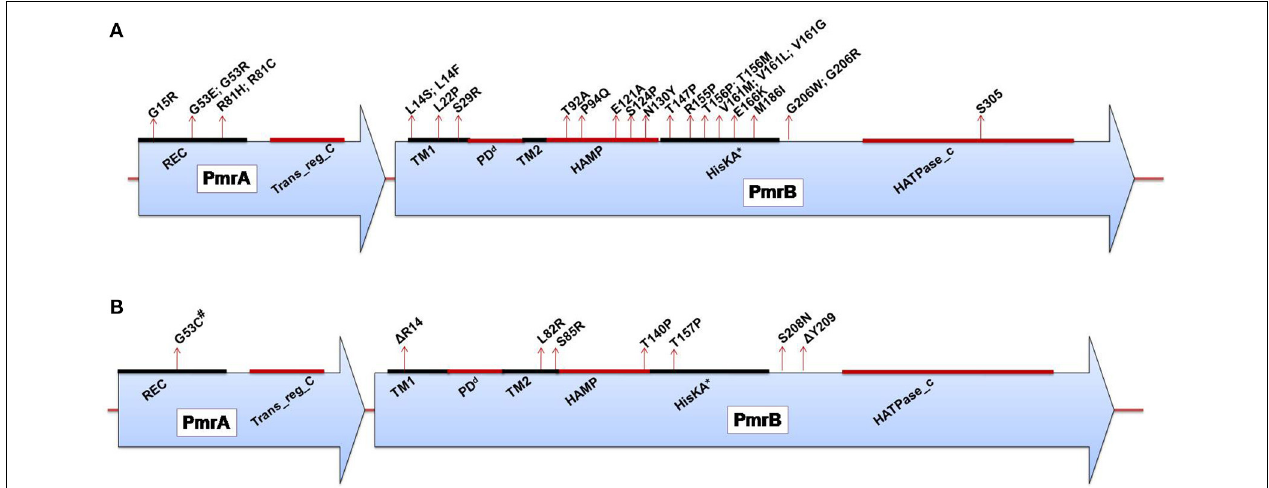
two-component system and positions of all mutations conferring polymyxin resistance to Klebsiella pneumoniae . PmrA domains , cheY-homologous